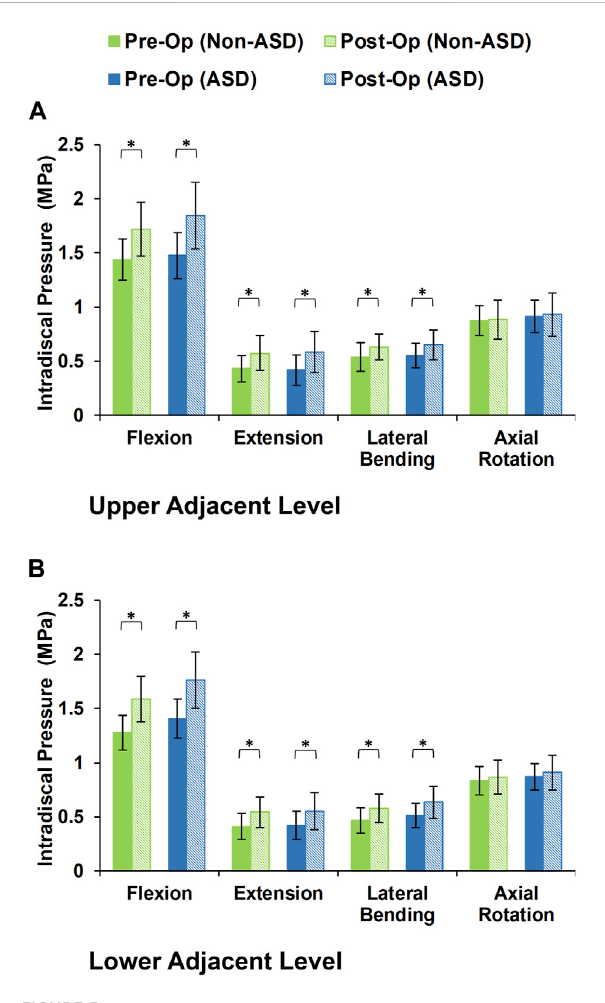
FIGURE 5 Calculated intradiscal pressure for non-ASD and ASD group FE models in the (A) upper and (B) lower adjacent level for different